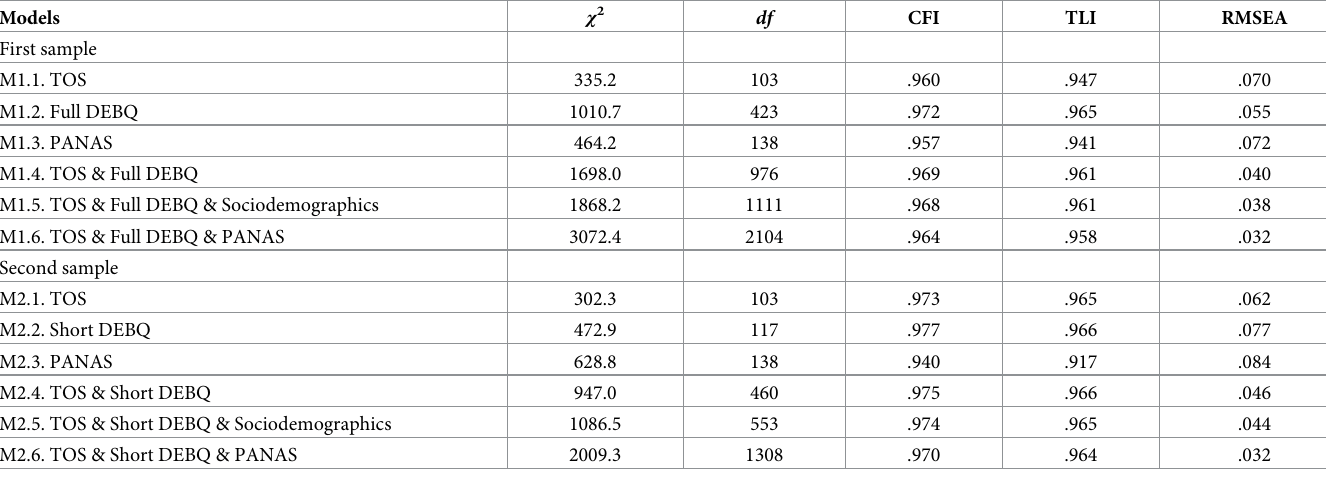
Table 1. Goodness of fit indices for the different